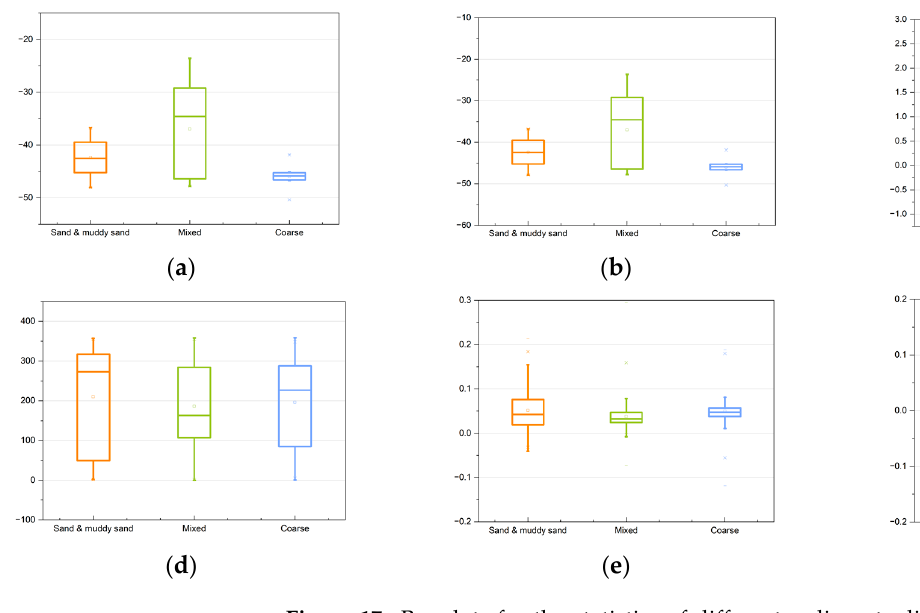
Figure 17. Boxplots for the statistics of different sediments distribution in topographic features. ( a ) Bathymetry; ( b ) mean depth; ( c ) slope; ( d ) aspect; ( e ) maximum curvature; ( f ) minimum curvature.